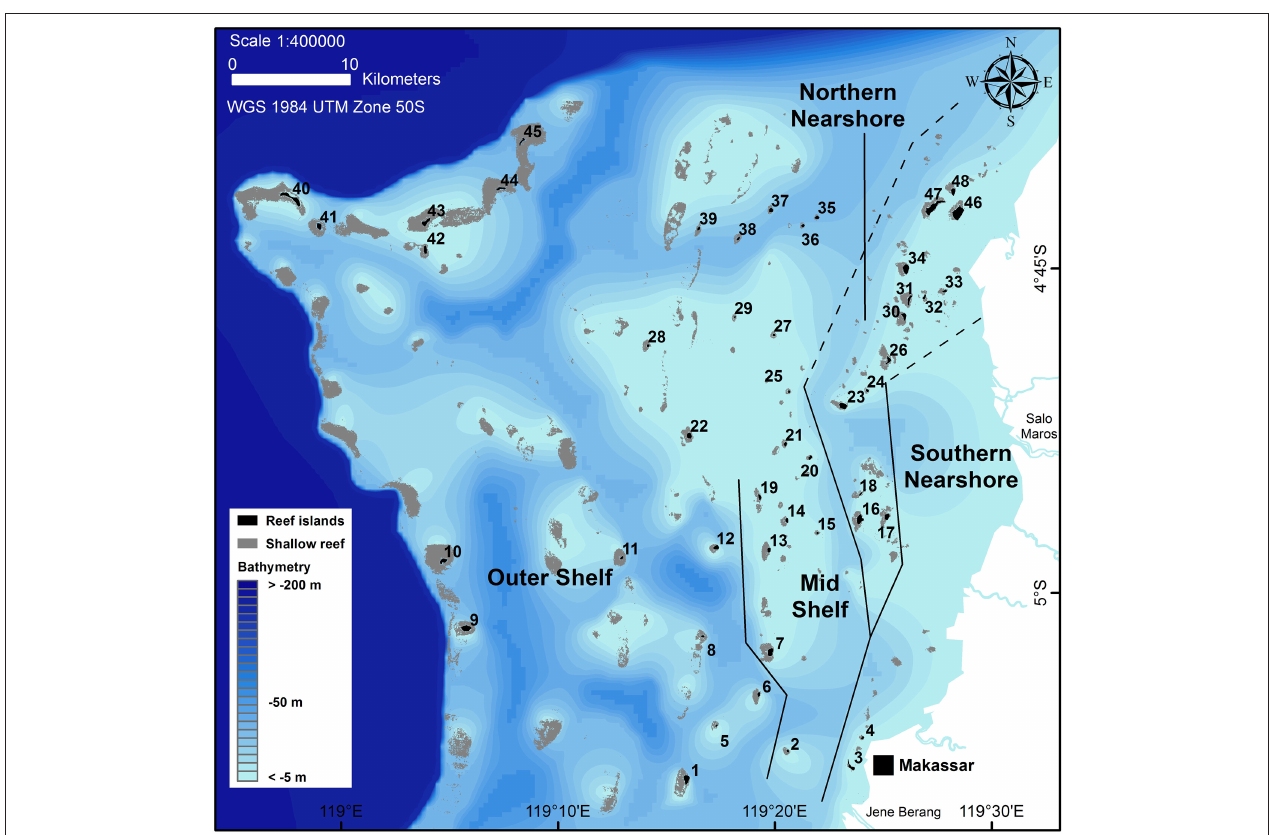
FIGURE 2 | Bathymetric map of the Spermonde Archipelago showing all named islands and larger reef structures. At the shelf break, the water depth increases to about 200 m. Zonation follows Renema (2002) with northern extensions inferred by the authors. Reef island numbers refer to islands names in Table 1 . A Supplementary Image 1 of this figure has been prepared without island numbers and shelf zonation. Bathymetry was reconstructed based on Landsat ETM data (Acquisition year 2002) and Renema